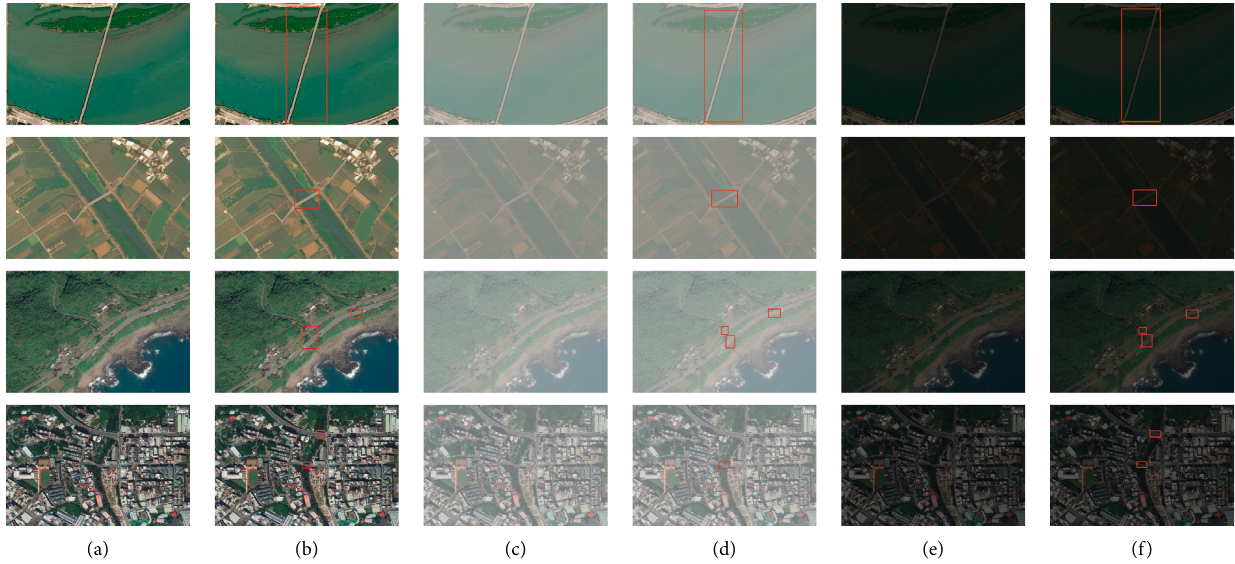
Figure 11: The comparisons of Faster R-CNN under normal, hazy, and low-light imaging conditions. F R-CNN represents the Faster